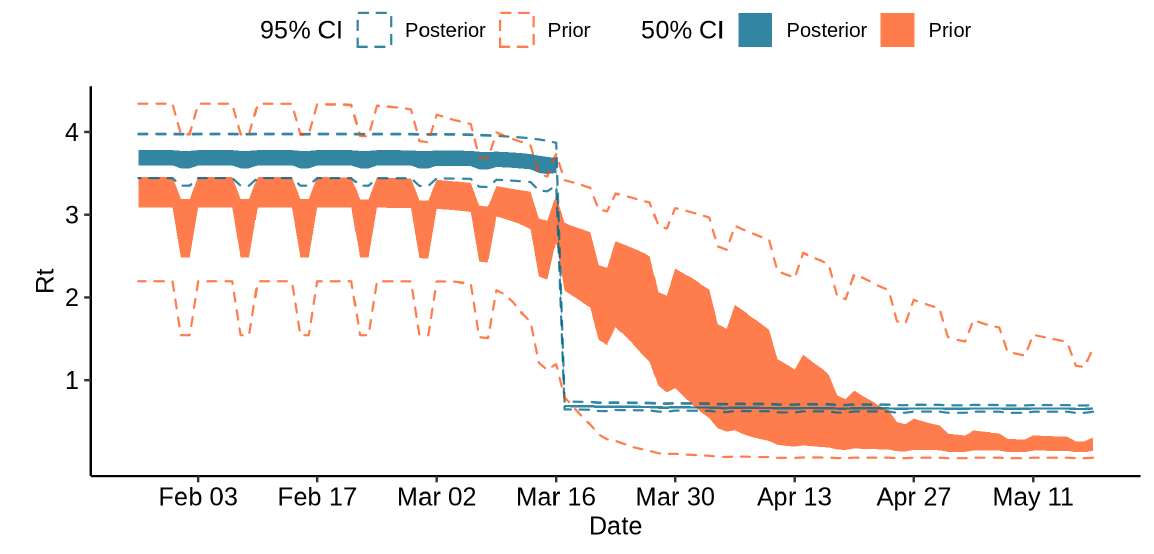
Figure 7 – Prior and posterior samples of R t in region